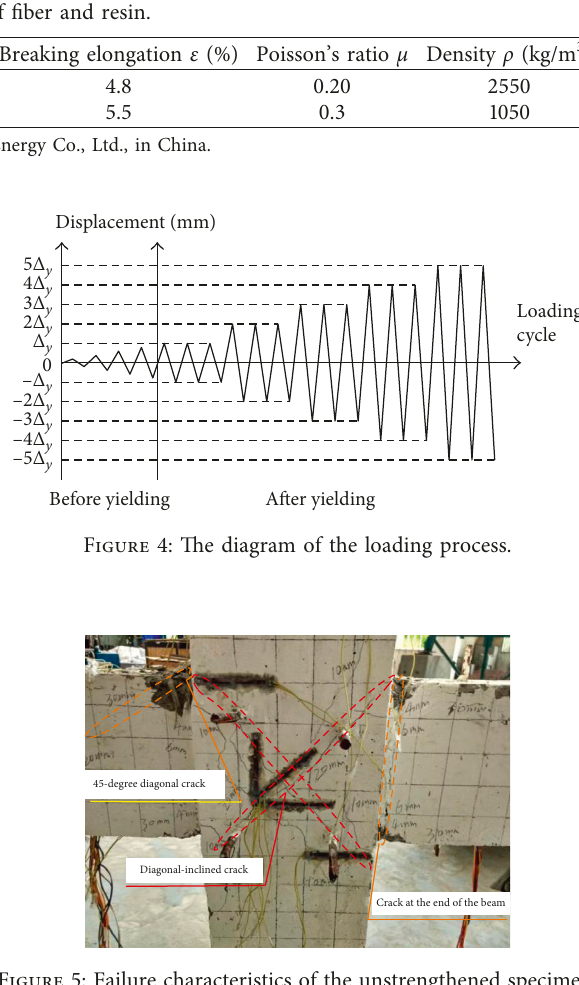
Figure 5: Failure characteristics of the unstrengthened specimen.